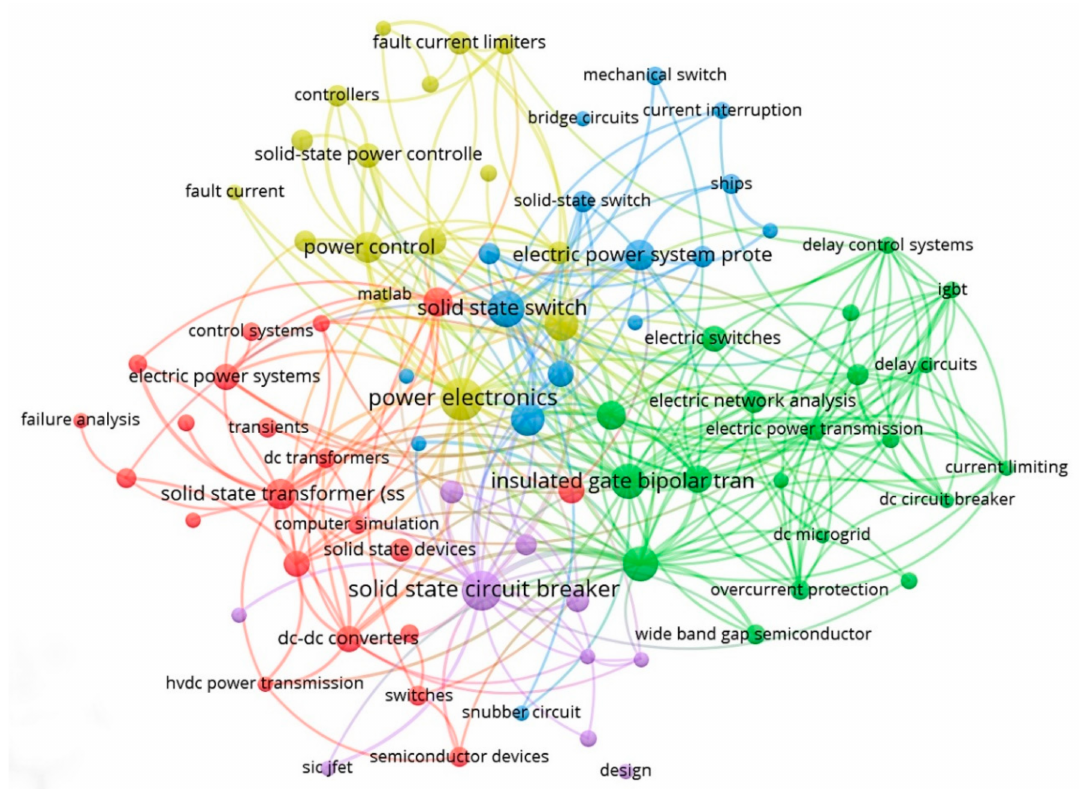
Figure 4. Co-occurrence map of keywords for 120 papers on solid state